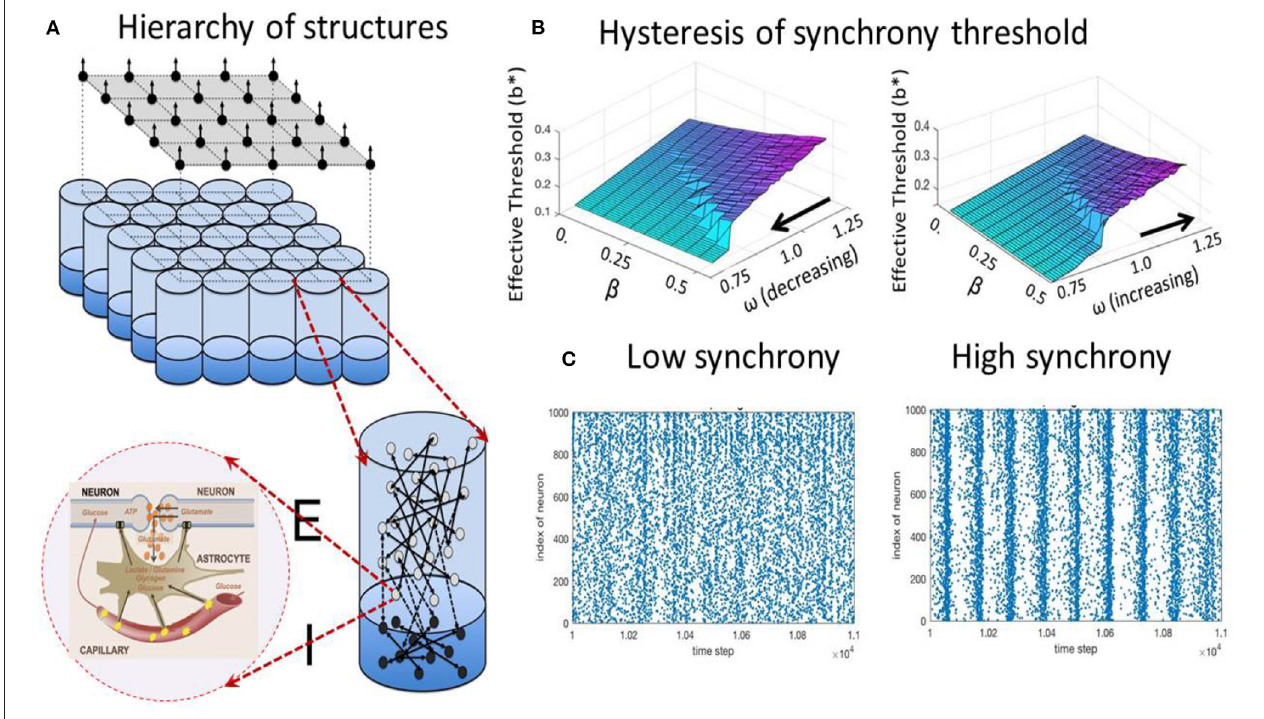
FIGURE 2 | Metabolic-neural model; (A) hierarchy of structures from cellular, mini-column, and mesoscopic population levels; (B) hysteresis effect on the transition between states with low (blue/turqoise) and high synchrony (purple); (C) examples of spiking raster plots for low and high